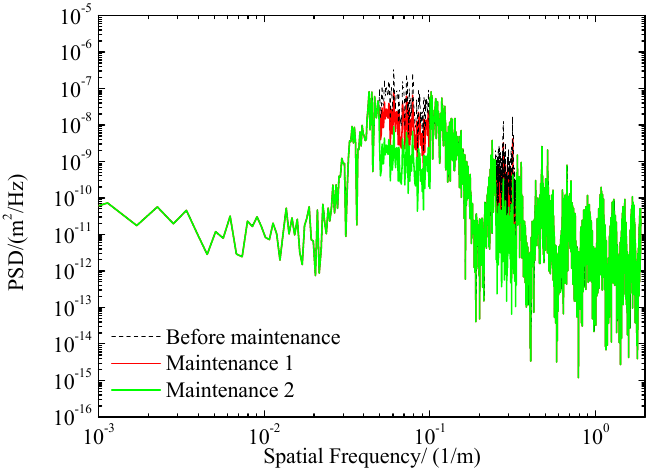
Figure 13. The two maintenance suggestions.